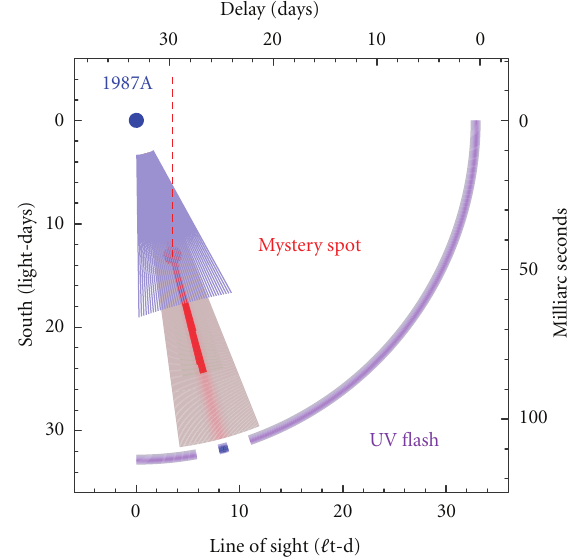
Figure 7: The relation of the Mystery Spot, near day 30, to a jet, a thinning shroud, and a UV Flash, when its projected o ff set from SN 1987A was 0.045 arcs.